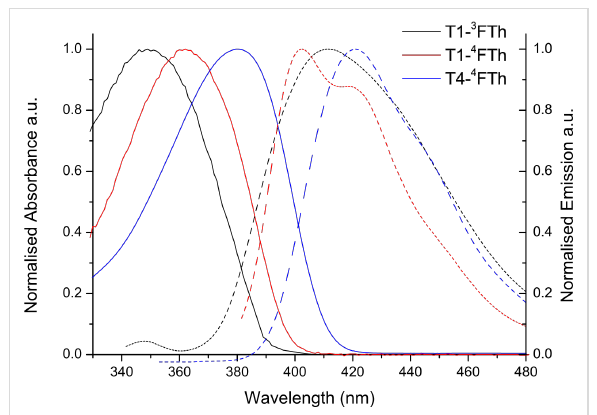
Figure 2: Normalised absorbance (solid) and emission (dashed) of materials in solution (dichloromethane).